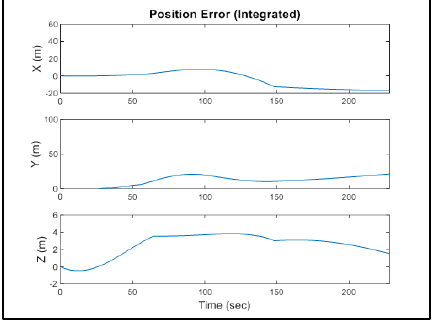
Figure 21. Position error of integrated system on the three axes